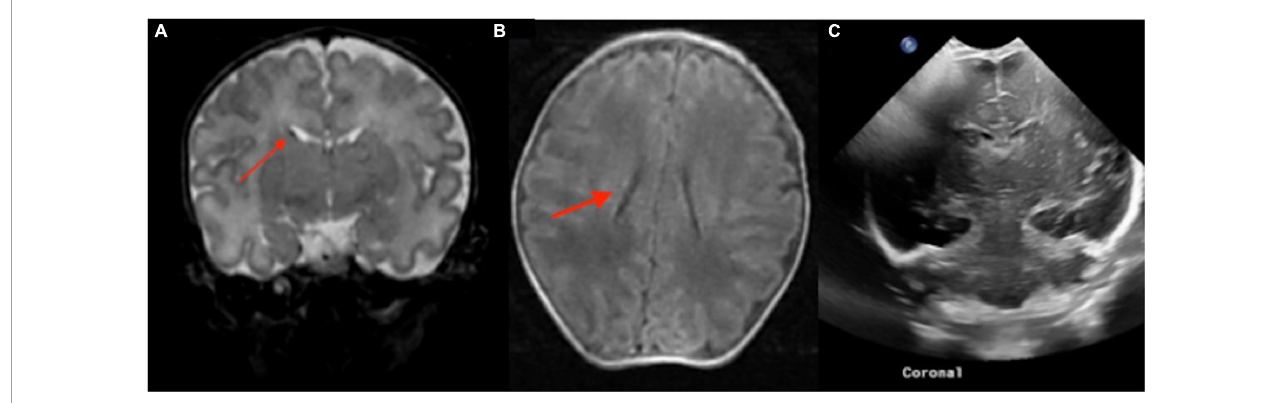
FIGURE7 The point of care 1-Tesla MRI in a 6-day-old infant with emergency cesarean section delivery due to decreased fetal movement and variable decelerations showed a possible punctate focus of hemorrhage versus vessel in the right caudothalamic groove with T2 hypointensity (A) and T1 hyperintensity (B) but no evidence of ischemic injury. This was not seen on transcranial ultrasound on the first day after birth (C) .